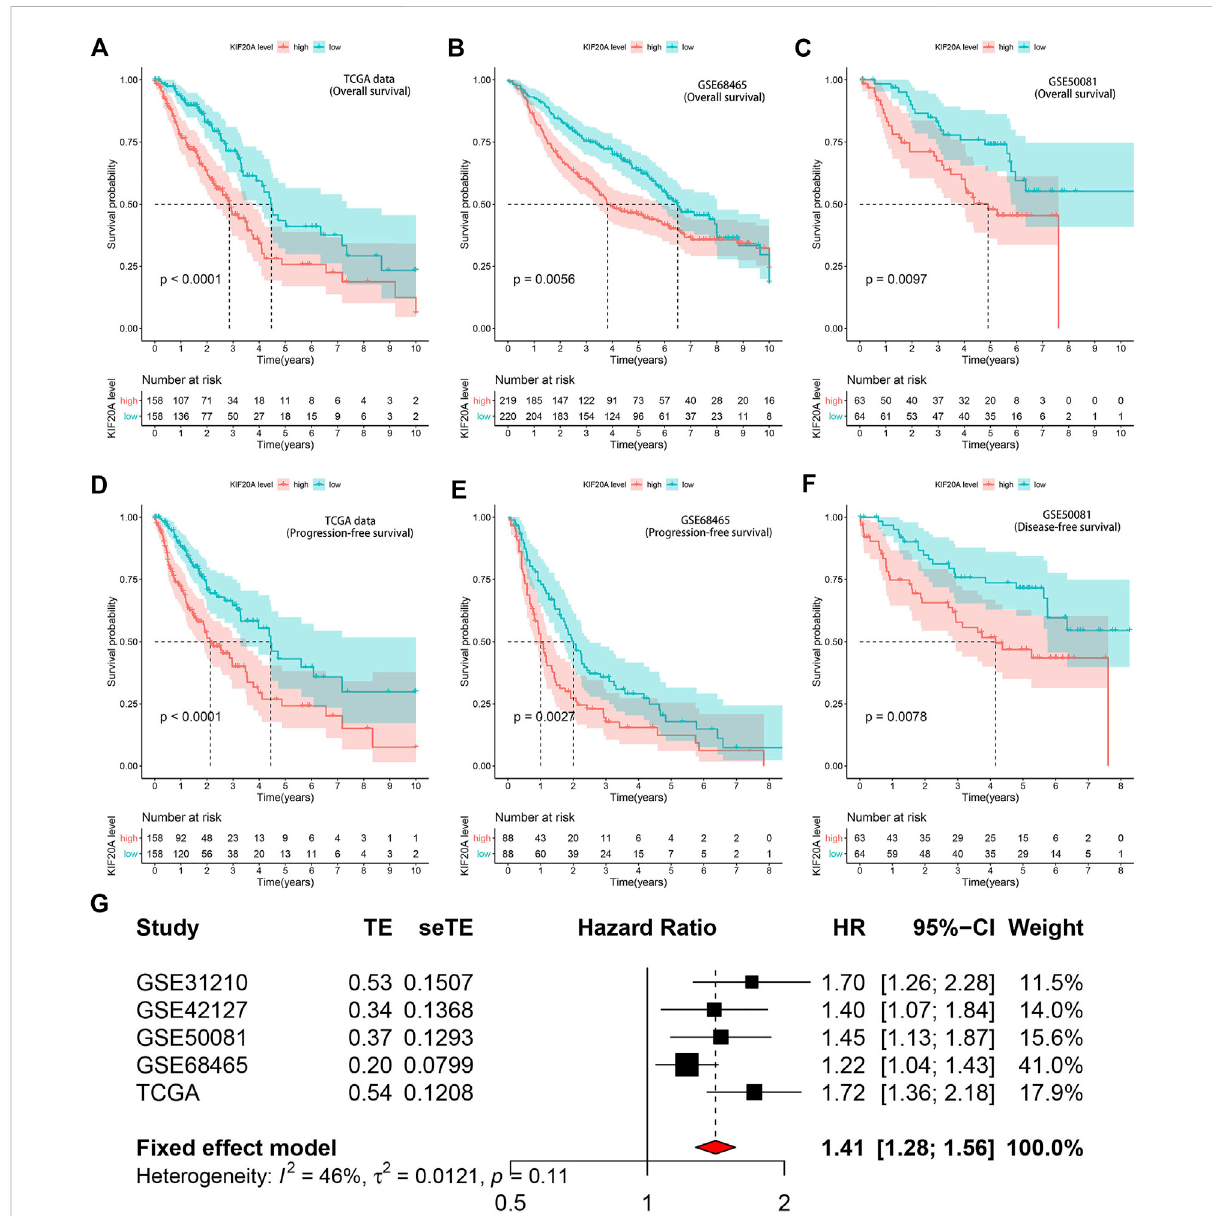
FIGURE 6 Prognostic value of KIF20A expression in LUAD. Kaplan-Meier survival analysis showed KIF20A expression signi fi cantly indicated worse OS in LUAD patients in the TCGA dataset (A) , GSE68465 (B) , and GSE50041 (C) pro fi les. Kaplan-Meier survival analysis showedthat KIF20A expression was negatively associated with progression-free survival (PFS) in the TCGA dataset (D) and GSE68465 pro fi le (E) , as well as disease-free survival (DFS) in the GSE50081 pro fi le (F) . The meta-analysis (G) further con fi rmed the correlation of KIF20A expression with OS in the fi ve